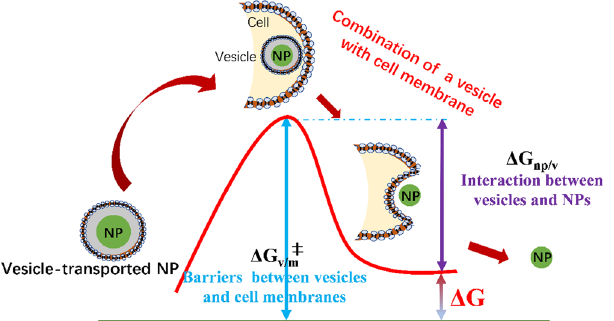
Figure 5. Energy profiles before and after combination of vesicles with cell membranes. Before the combination of vesicle-transported NPs with cell membranes, the energy barrier ( ΔG v/m ‡ ) between vesicles and cell membranes prevent the two from combining. At the moment of combination, the interaction (repulsive) energy ( ΔG np/v ) between the NPs and the vesicles promote the NPs to desorb from the membrane to detach. ΔG is the energy change at the combination moment ( ΔG v/m ‡ minus ΔG np/v